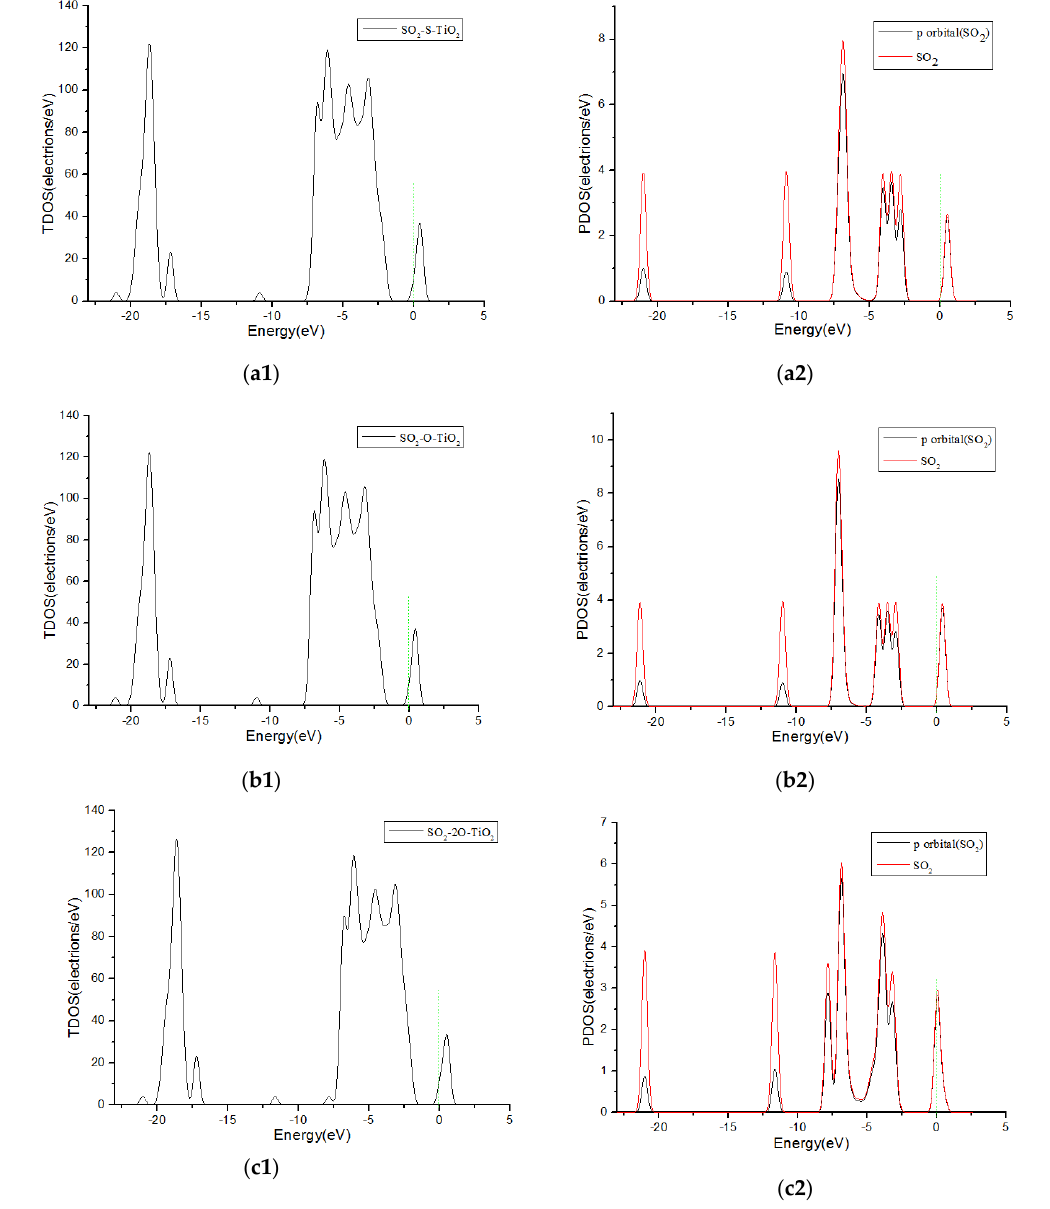
Figure 5 . The total density and partial density of SO 2 molecules adsorbed on F-doped TiO 2 , and the green short dashed line is Fermi level. ( a1 , a2 ) are the TDOS and PDOS of SO 2 -S-TiO 2 , ( b1 , b2 ) are the TDOS and PDOS of SO 2 -O-TiO 2 , ( c1 , c2 ) are the TDOS and PDOS of SO 2 -2O-TiO 2 .